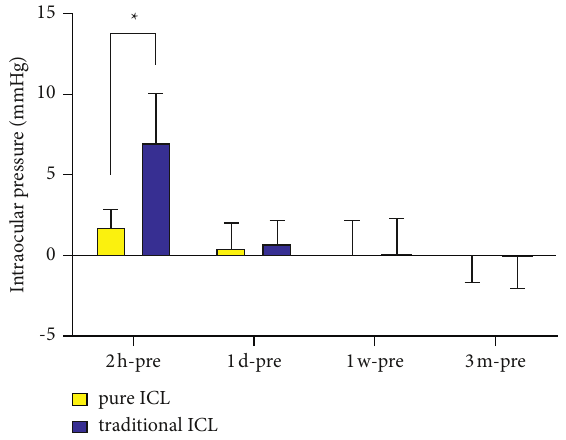
Figure 5: The difference of intraocular pressure between baseline (preoperation) and each postoperation time point in eyes under- going the pure ICL implantation and traditional ICL